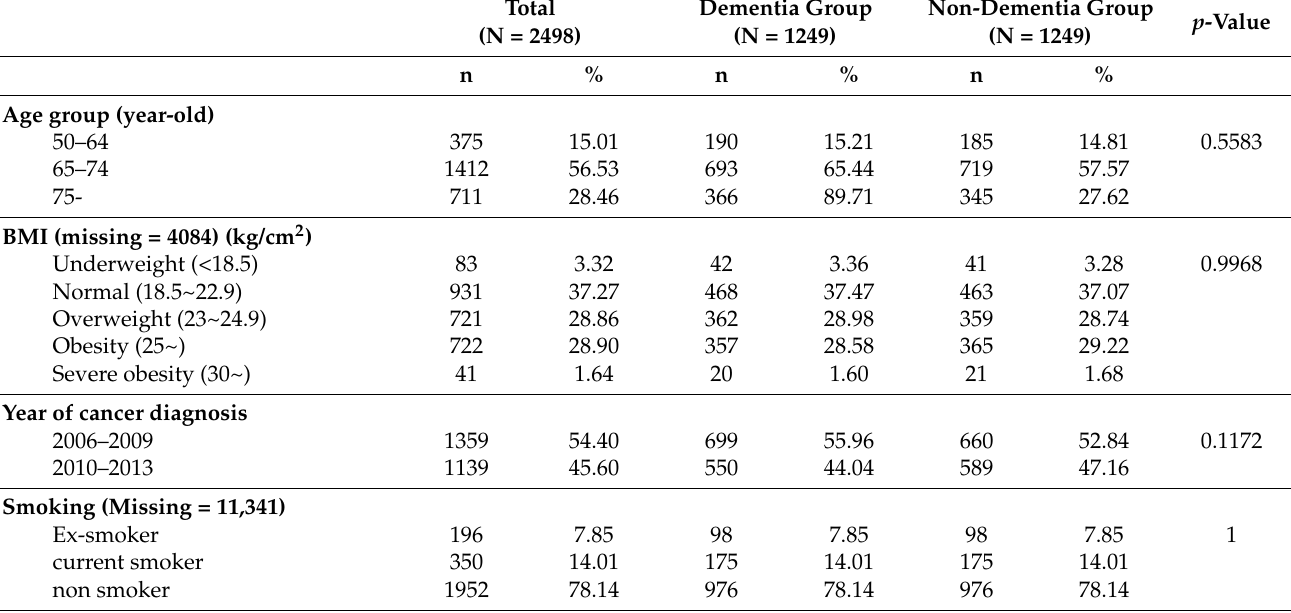
Table 3. Comparison of the demographic characteristics between dementia and non-dementia groups among patients with prostate cancer after 1:1 propensity score matching adjusted variables for age, SEER stage, diagnosed year, aspirin use, statin use, BMI, smoking, hypertension, diabetes mellitus, and cardiovascular